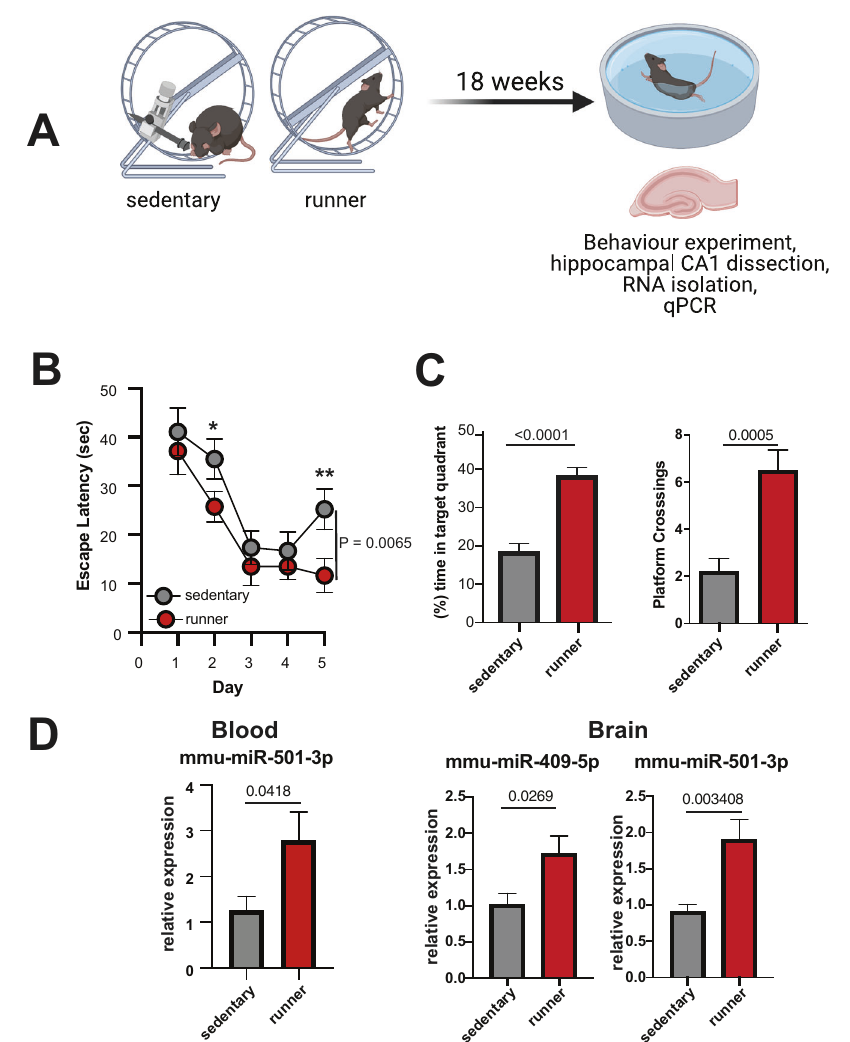
Fig. 3 Increased expression of microRNA-409-5p and microRNA-501-3p in the hippocampus of mice upon exercise. A Experimental design. Mice of the experimental group (runners; n = 10) had free access to running wheels for voluntary exercise during a period of 18 weeks. Mice of the control group ( n = 10) were housed under similar conditions but the running wheels were blocked (sedentary). After 18 weeks mice were subjected to a water maze-based spatial memory test and subsequently, hippocampal sub-regions were microdissected for molecular analysis. B Escape latency during the 5 days of training. Two-way ANOVA revealed a signi fi cant difference amongst groups ( P = 0.0065, F = 7.7). Post hoc analysis revealed signi fi cant differences when comparing the performance on day 2 and day 5 amongst groups ( * P < 0.1, unpaired t test; ** P < 0.05, unpaired t test). C Left panel: The time spent in the target quadrant during a probe test performed after 5 days of training was signi fi cantly increased (19.86 ± 3.14; mean ± SEM) in the runners-group ( n = 10/group, unpaired t test, parametric, two- tailed). Right panel: Similarly, the number of platform crossings during the probe test was signi fi cantly higher in the runners-group ( n = 10/ group, unpaired t test, parametric, two-tailed). D Left panel: Bar graph depicting qPCR results showing increased expression of microRNA-501- 3p in blood samples collected from mice before and after completion of the exercise procedure ( n = 8/group unpaired t test, parametric, two- tailed). Please note that we could not detect microRNA-409-5p in blood samples from mice. Right panel: Bar graphs showing the qPCR expression of microRNA-409-5p and microRNA-501-3p in the hippocampal CA1 region. MicroRNA levels were increased in the runners-group ( n = 9/group, unpaired t test, parametric, two-tailed). Error bars indicate mean ± cultures were treated with LNPs containing the mixture anti-miRs. After 72 h incubation the plate was transferred to MEA device for further recording. When compared to scramble controls, anti-miR- mixture treatment led to signi fi cant reduction in neuronal weighted mean fi ring rate, number of bursts and number of network bursts (Fig. 5E).